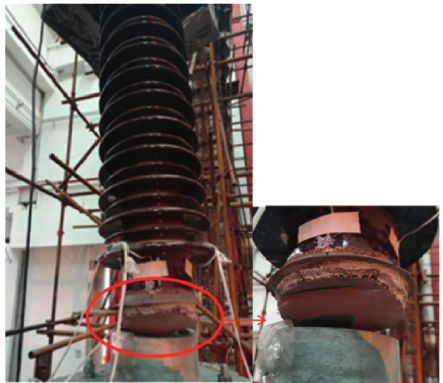
Figure 2: Failure of 110kV post insulator after shaking table